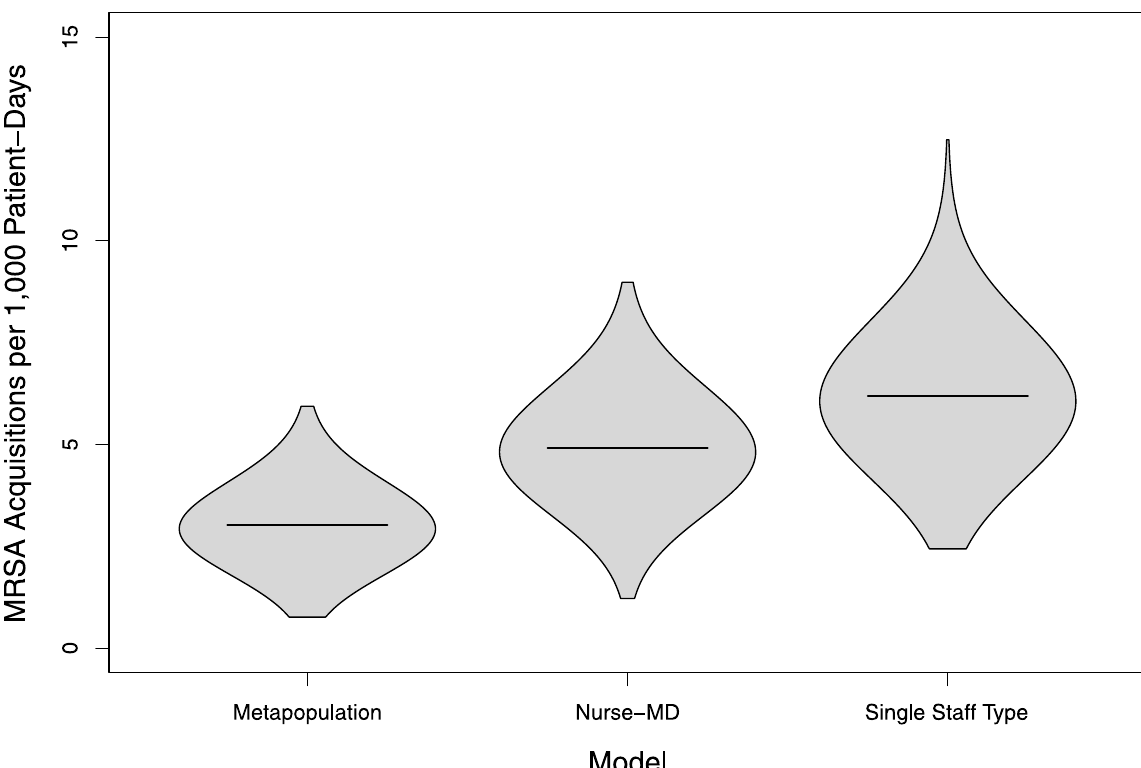
Fig 2. Distribution of cumulative MRSA acquisitions in 3,000 simulated 18-bed intensive care units under three theoretical population structures.